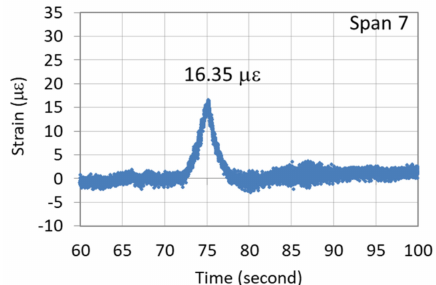
Figure 8. Dynamic strain response of the G5 girder of the seventh span when the vehicle passed over the girder.